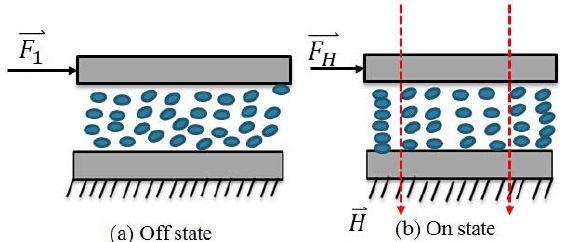
Figure 2. Magnetorheological fluids (MR fluids) effect with external magnetic field or without. ( a ) Off state; ( b ) On state.